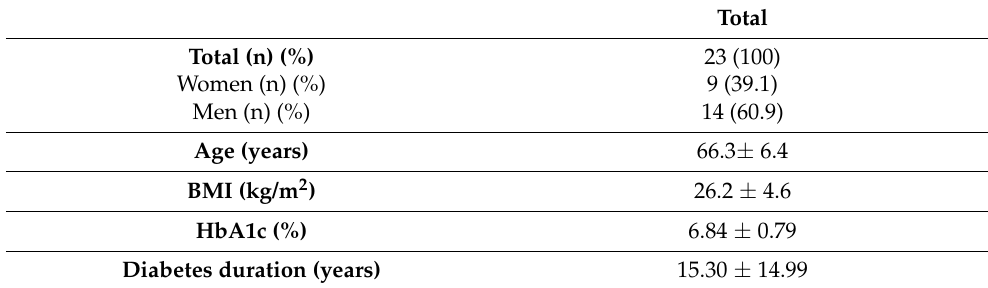
Table 1. Participants’